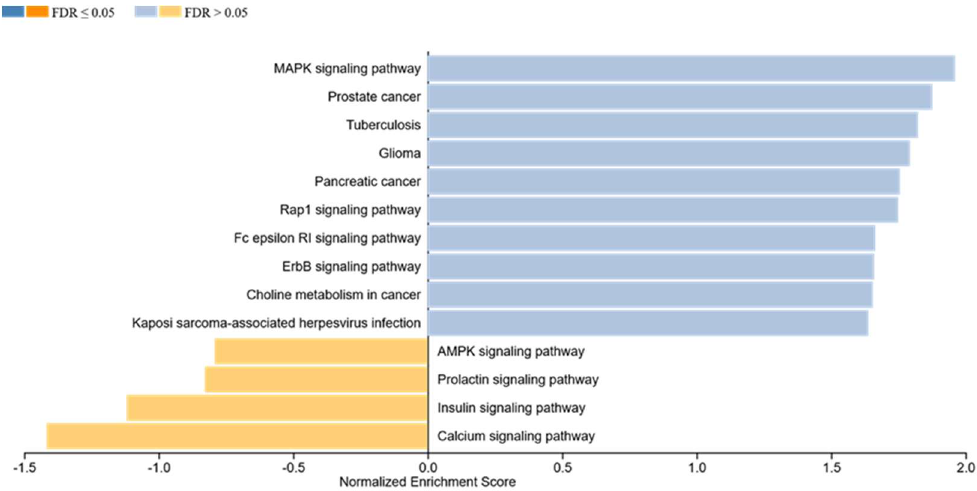
Figure 4. Gene set enrichment analysis in relation to apoptosis in MPM cells being treated with FB CM. Particularly, the MAPK− RAP1 and the Fc receptor signaling pathway showed significant associations. These pathways were activated in treated MPM cell lines.